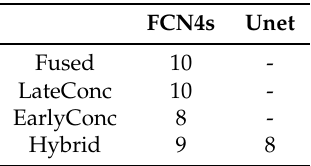
Table 2. Number of epochs used to train different